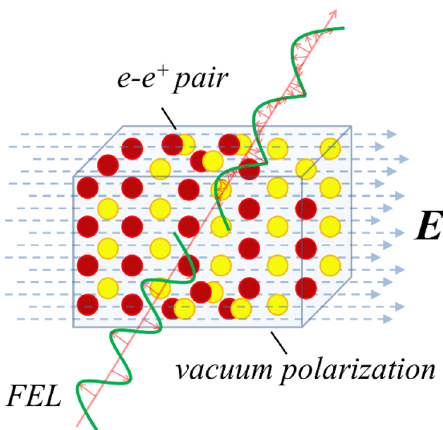
Figure 9 . Schematic of the vacuum Kerr effect. The Dirac vacuum is strongly polarized under an extreme electric field whose strength approaches the Schwinger threshold. Just as the birefraction in a polarized dielectric medium, a linear polarized FEL beam can transfer into an elliptical polarized beam after it propagating through the polarized